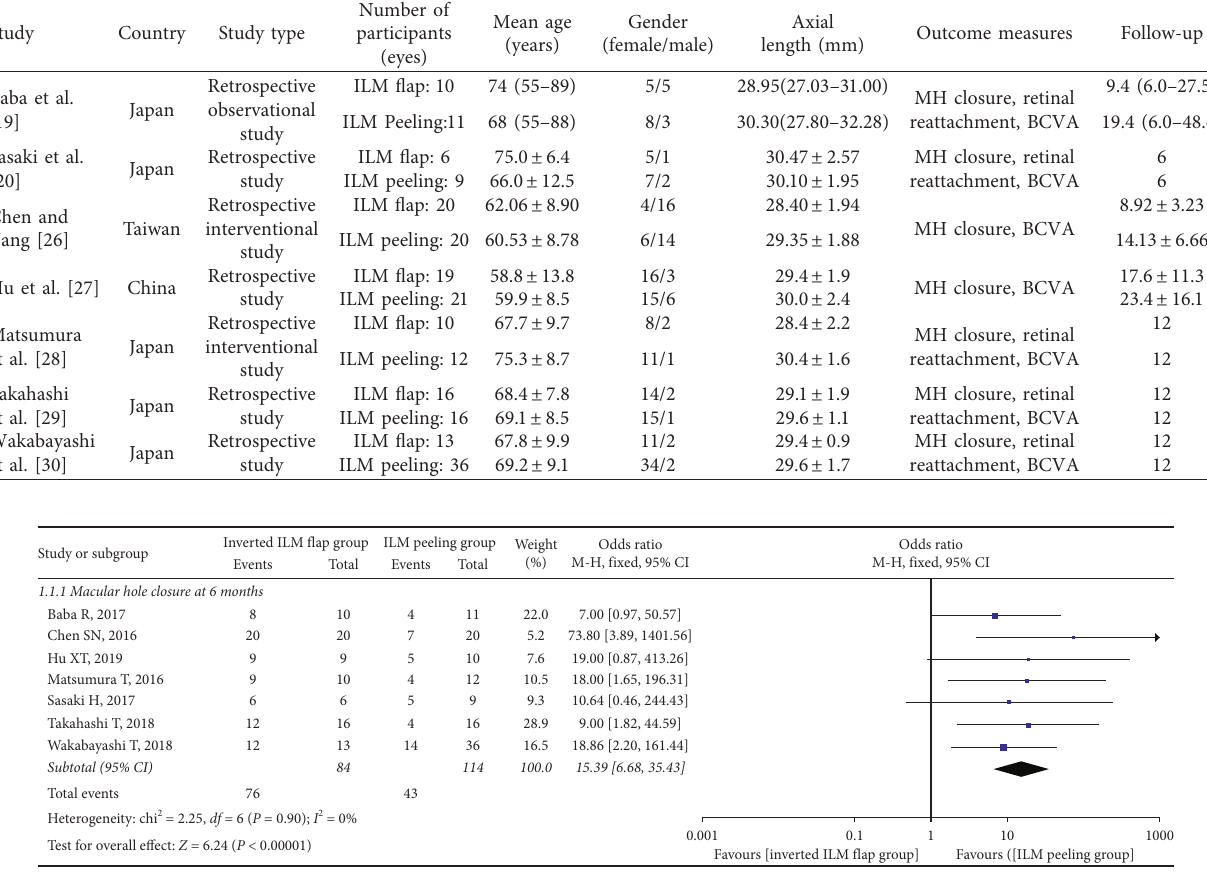
Figure 2: Forest plot comparing macular hole closure rate between inverted ILM flap and ILM peeling groups at 6 months after surgery. ILM � internal limiting